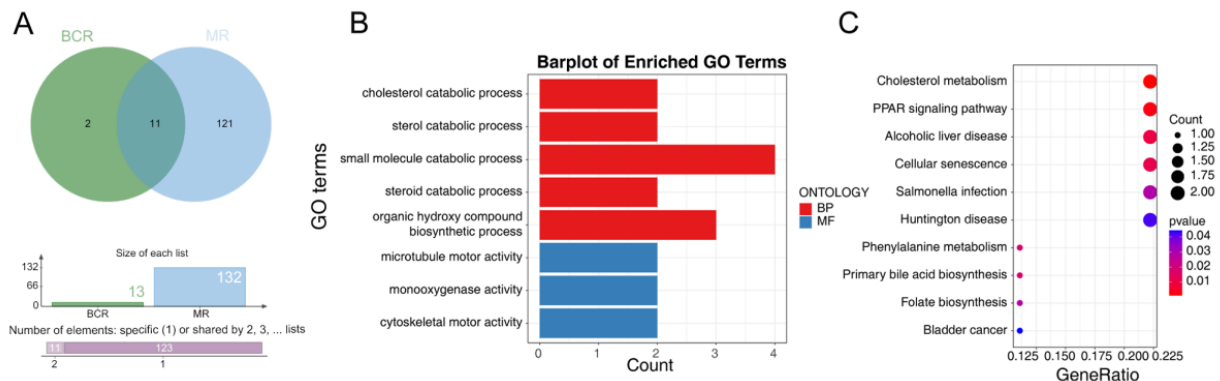
Figure 1. Identification and enrichment analysis of the DE-MR-BCRGs. ( A ) Venn Diagrams of DE- MRGs and BCR-DEGs. ( B ) GO enrichment analysis. ( C ) KEGG enrichment analysis. DE-MRGs and BCR-DEGs. ( B ) GO enrichment analysis. ( C ) KEGG enrichment